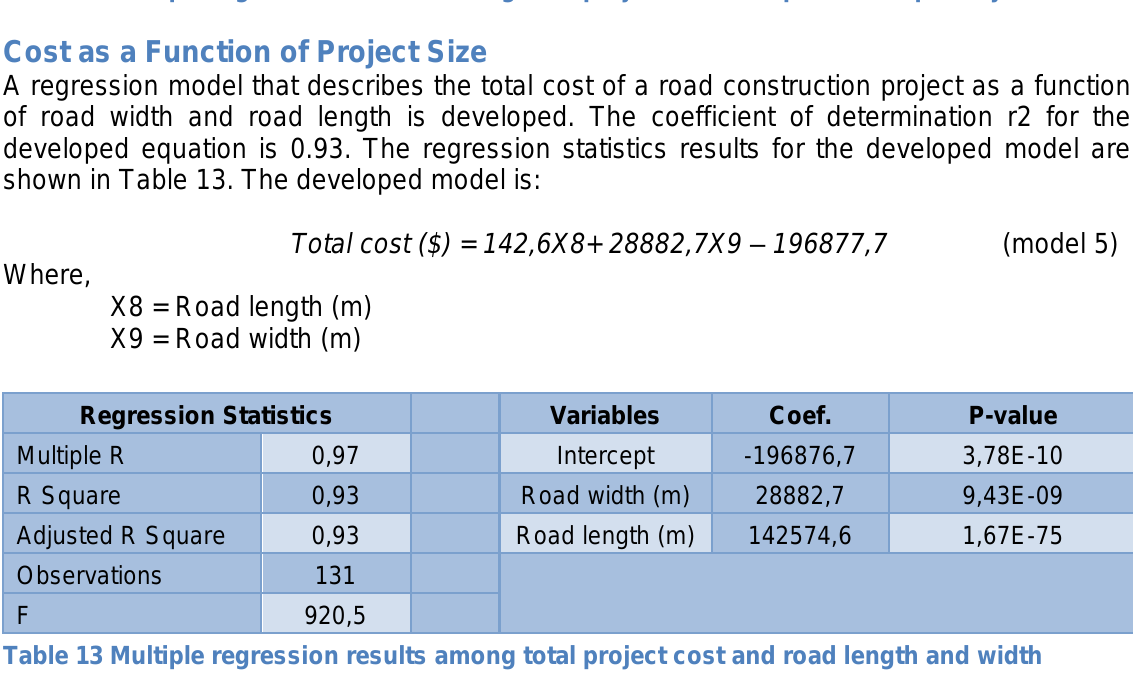
Table 12 Multiple regression results among total project cost and pavement quantity